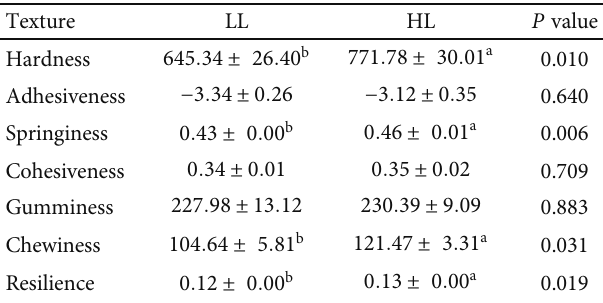
Table 5: Texture of white muscle of blunt snout bream fed the trial diets ( Mean ± SEM , n = 4